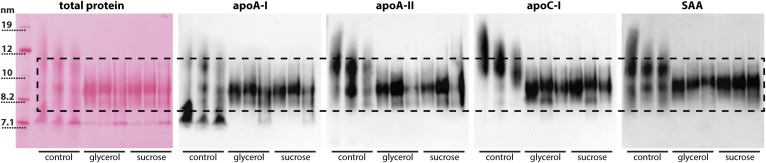
Immunoblot analysis of HDL stored with and without cryoprotectants. HDL was isolated from serum by density gradient ultracentrifugation. HDL was stored at −20°C or −70°C in the presence or absence of 25% glycerol or 5% sucrose for 25 weeks. Three samples for each condition (control, glycerol, or sucrose) from three individual donors are shown. Proteins were separated by native gel electrophoresis and blotted onto PVDF membranes. Blots were probed using antibodies for apoA-I, apoA-II, apoC-I, and SAA. Total protein was visualized after blotting by Ponceau red staining. The dashed line indicates the typical size range of HDL2 and HDL3 ranging from about 8 to 12 nm.